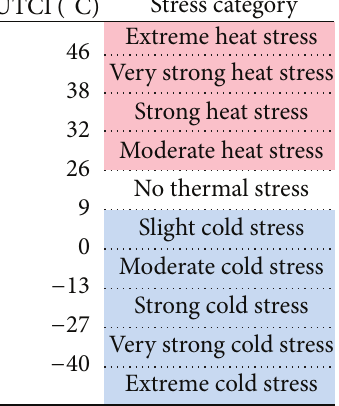
Figure 3: UTCI range with corresponding stress category for humans [21]. Blue represents cold stress classes, white represents no thermal stress, and red represents heat stress